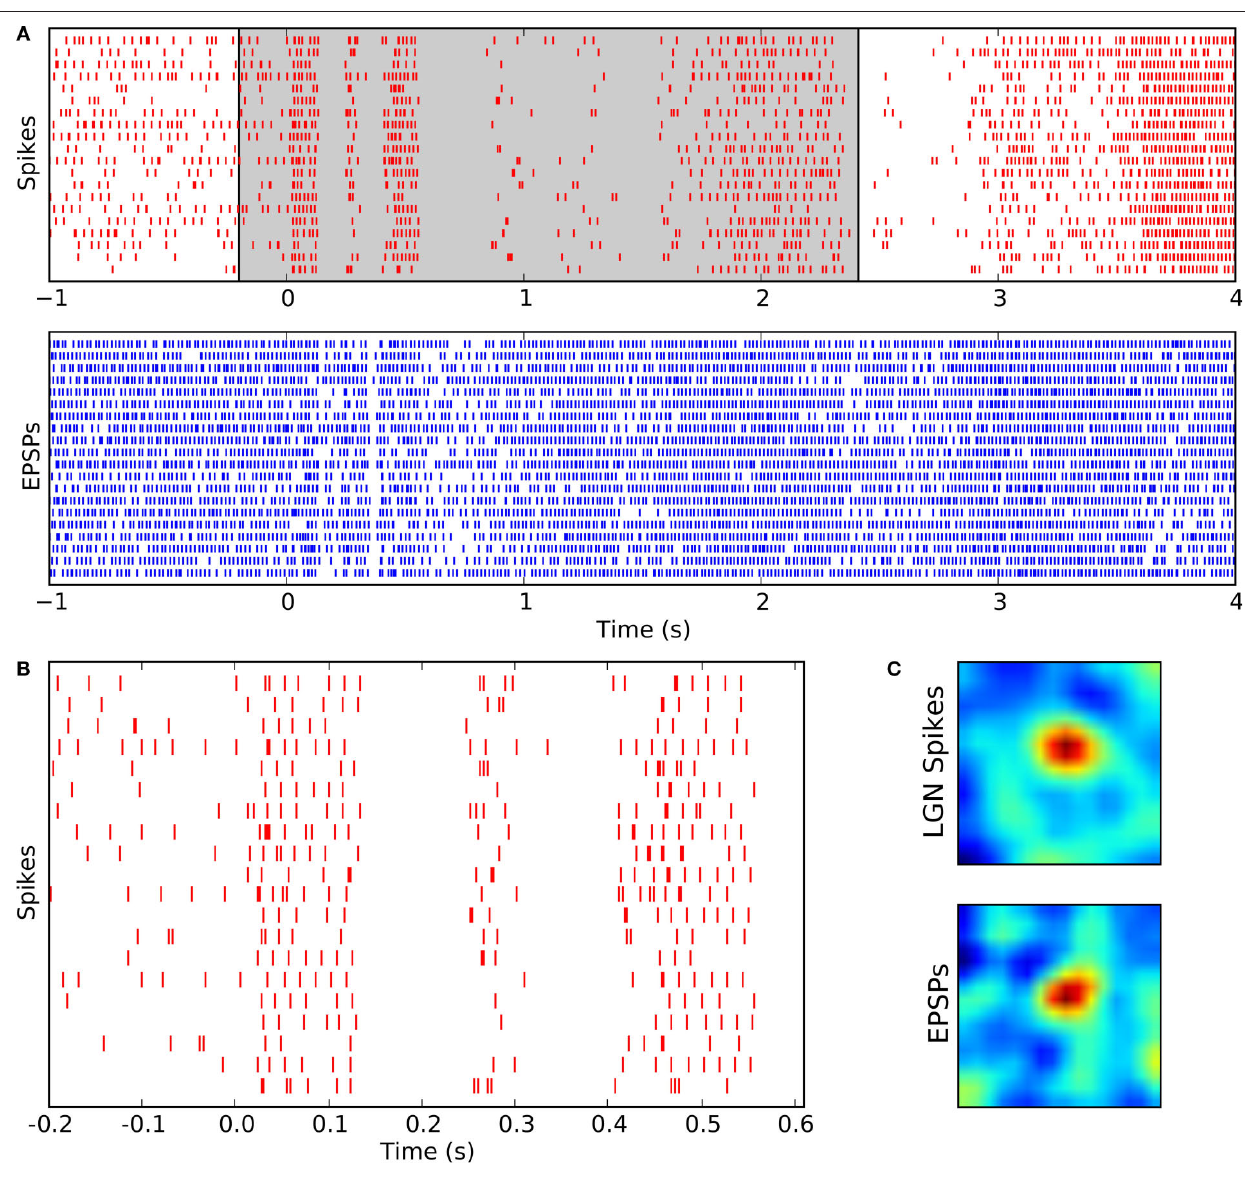
marks the data range that is shown in (B) at higher magnifi cation. (B) Spike times centered on the beginning of each clip shown at an expanded scale. (C) Receptive fi elds for spikes (top) and EPSPs (bottom) mapped from responses to a movie; red indicates excitation to bright and blue excitation to